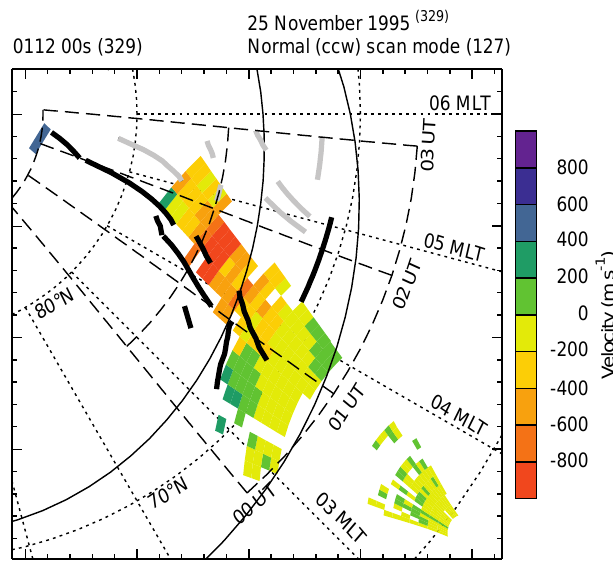
Fig. 7. The locations of optical features presented in FIGURE 3 projected into GMLAT/MLT coordinates for a projection altitude of 250 km, superimposed on a spatial plot of the CUTLASS Finland backscatter velocities measured at 0112 UT. This projection is based on the time-independent hypothesis described in the text. The location of the MSP meridian is indicated for 00 UT, 01 UT, 02 UT, and 03 UT, as are the projection of zenith angles 0 (cid:176) and (cid:139)80 (cid:176) . The location of the K p (cid:136) 1 auroral oval is also indicated for 0112 UT. Optical arcs indicated in grey are thought to be associated with an auroral activation after 0205 UT, and as such time-dependent and not appropriate for this mapping